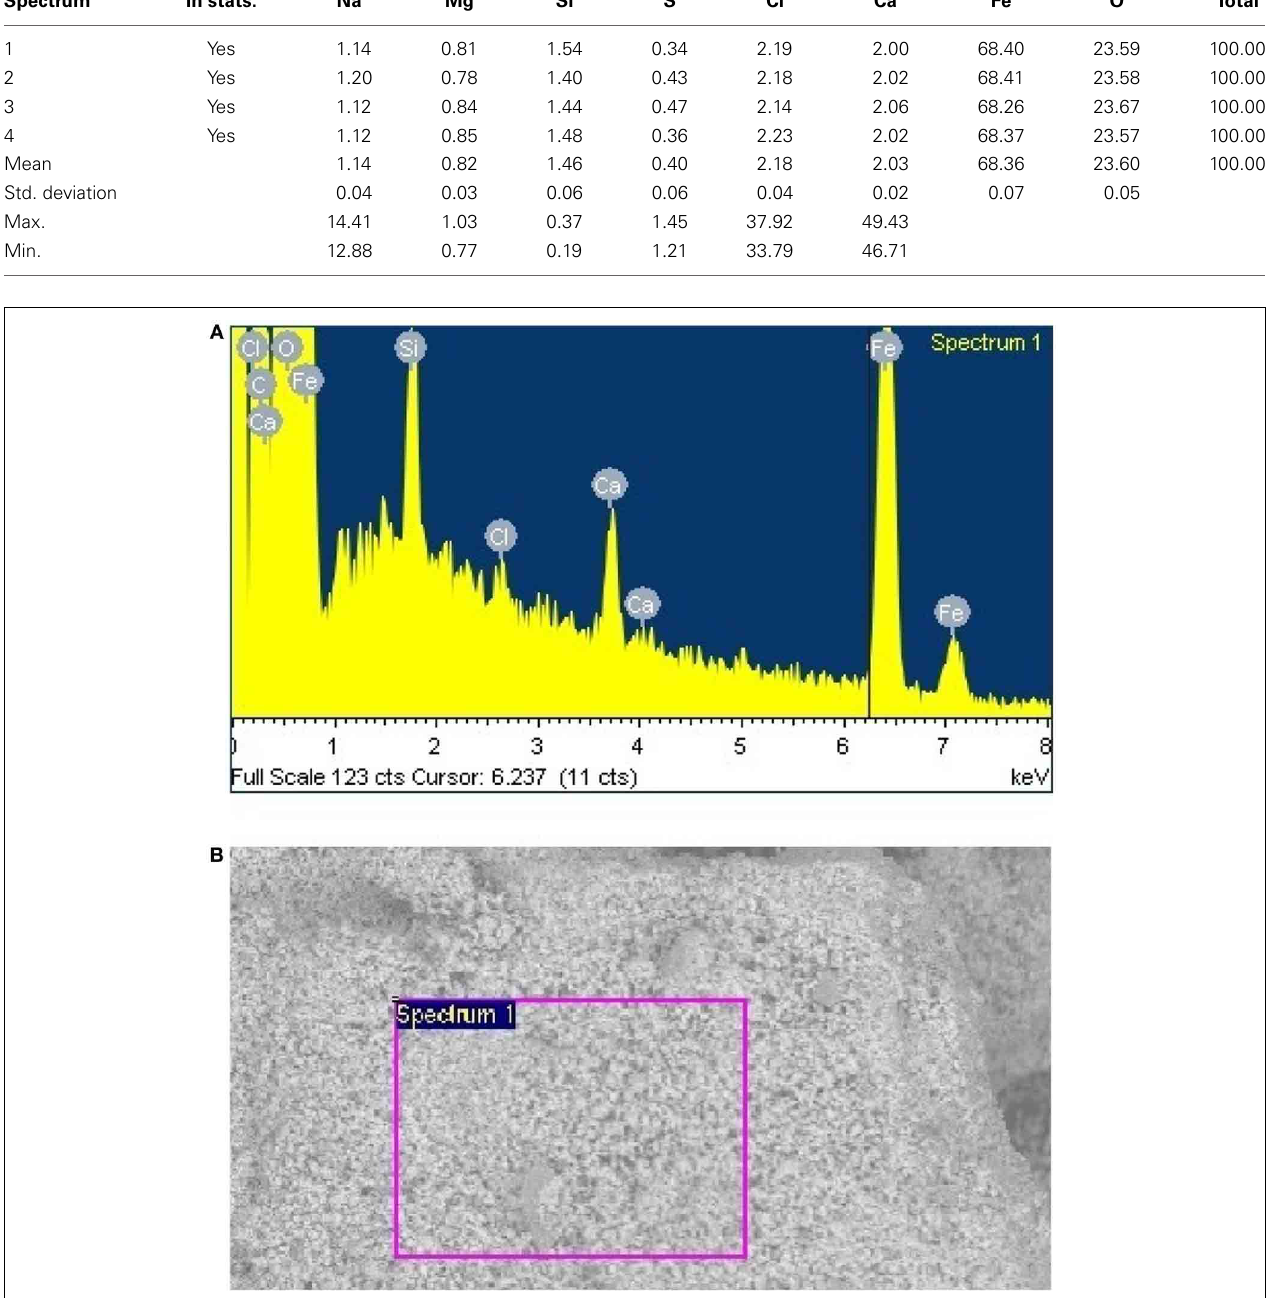
FIGURE 8 | (A) Site of observation for the samples from GS treatment (B) Elemental analysis data obtained from spectrum one.